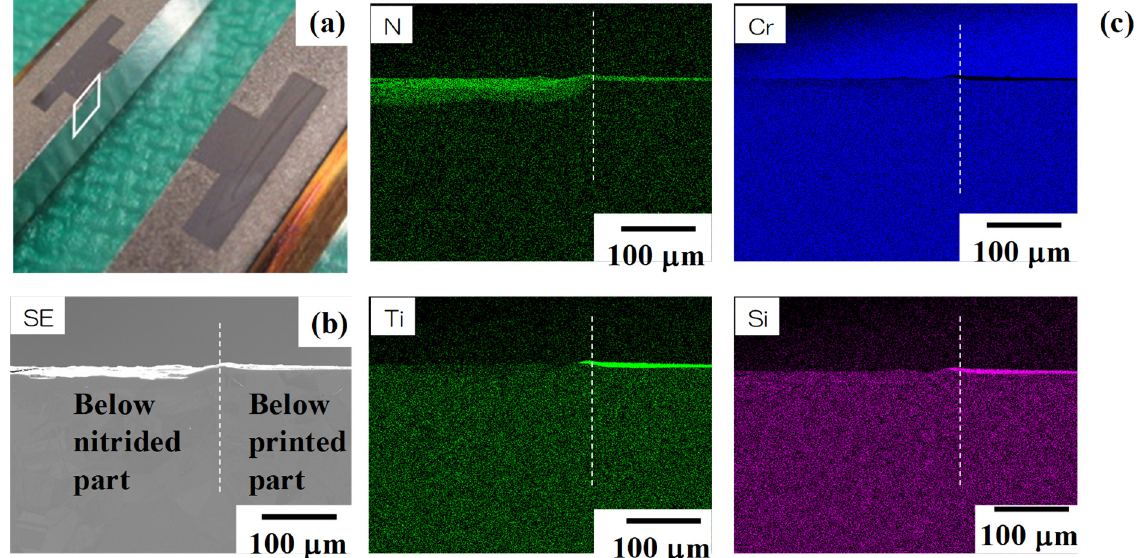
Figure 7. SEM-EDX analyses on the cross-section of T-shaped substrate in Figure 5b. ( a ) The cross- section of T-shaped AISI316L substrate, ( b ) SEM image on the cross-section across the border between the unprinted and printed zones, and ( c ) element mapping of N, Cr, Ti, and Si on the